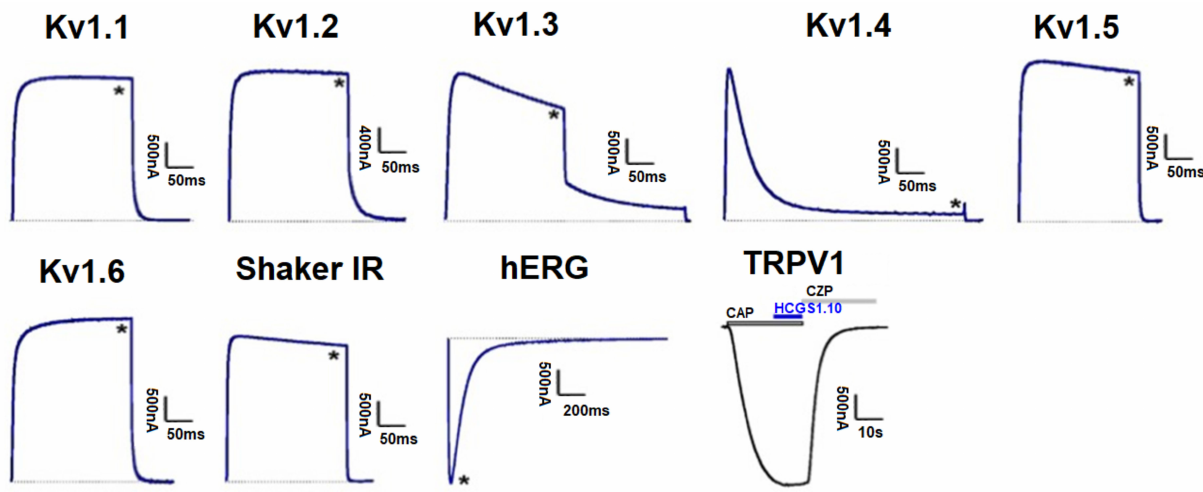
Figure 7. Differential effects of HCGS1.10, HCGS1.36, HCGS1.19, and HCGS1.20 on Kv isoforms and TRPV1 expressed in Xenopus laevis oocytes. Representative whole cell K + current traces of oocytes expressing cloned Kv isoforms Kv1.1-Kv1.6, hERG (Kv11.1) and the Drosophila channel Shaker IR. The dotted line indicates zero-current level. The asterisk (*) indicates the steady-state current peak amplitude in the presence of 10 µ M HCGS1.10, HCGS1.36, HCGS1.19, and HCGS1.20. Whole- cell current traces in HCGS1.10 conditions co-applied with capsaicin (CAP = 2 µ M); capsazepine (CZP = 10 µ M) are shown. The image was carried out by pClamp Clampfit 10.0 (Molecular Devices, Downingtown, PA, USA) and Origin 7.5 software (Originlab, Northampton, MA, USA).